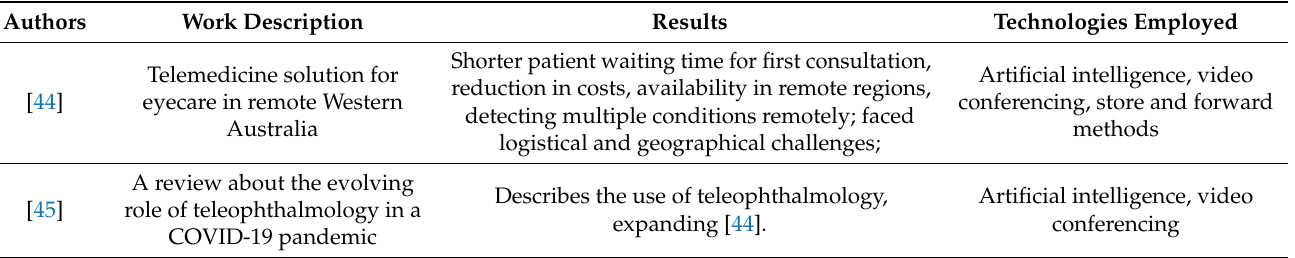
Table 4. Telemedicine